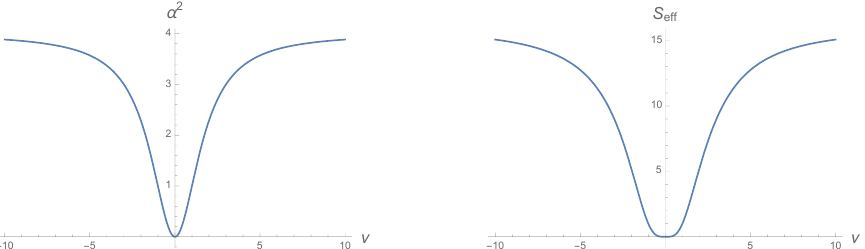
Figure 6 . The parameter (cid:11) 2 and the e(cid:11)ective entropy S e(cid:11) versus deforming factor (cid:23) . The left plot could give a (cid:12)rst estimation of the number of chiraleon gates versus the deformation of the geometry and the right one could show a c-like theorem for WCFTs as the e(cid:11)ecting action is a monotonically increasing function of the physical positive values of (cid:23)